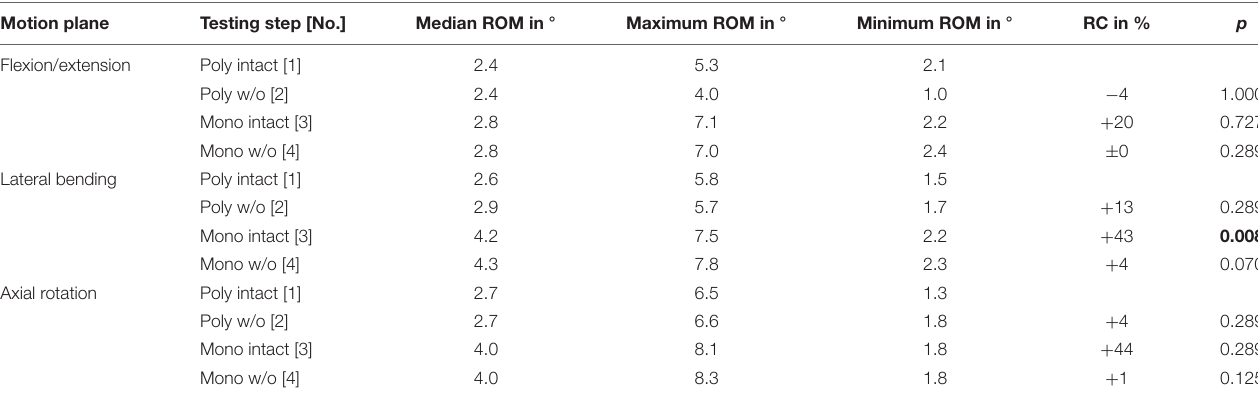
TABLE 9 | Results for T11-T12 range of motion at pure moments of ± 5 Nm ( n = 8) depending on primary motion plane and testing step. Motion plane Testing step